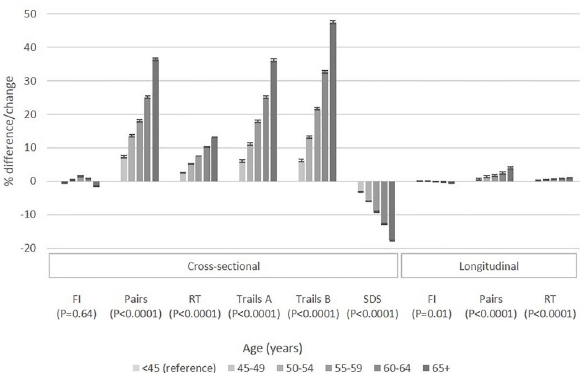
Fig 1. Percentage difference/change in cognition scores with age based on cross-sectional (difference) and longitudinal (change) analysis. To allow comparison across cognitive tests, cognitive difference (cross-sectional) or change (longitudinal) are expressed as a percentage difference/change as a function of the range of each test (See Analyses). Negative % difference/change in FI and SDS represents a lower/decline in performance. Positive % difference/change in Pairs, RT, Trail A and Trail B represents a lower/decline in performance. With increasing age category, Pairs, RT, Trail A, Trail B and SDS significantly changed by 5.9, 2.6, 6.0, 7.8 and 3.4% according to cross- sectional analysis. With increasing age category, Pairs, and RT significantly declined by 1.2 and 3.0% according to longitudinal